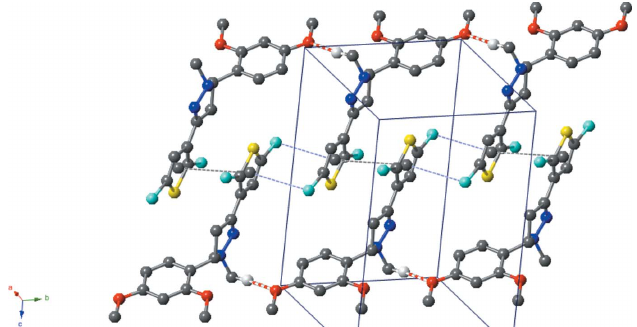
Figure 2 A packing view of I showing layers parallel to bc plane assembled through C—H (cid:3)(cid:3)(cid:3) O (rendered multi-band cylinders), Cl (cid:3)(cid:3)(cid:3) (cid:2) (gray dashed lines) and (cid:2) – (cid:2) (blue dashed lines) interactions. Hydrogen atoms not involved in interactions are omitted for clarity.